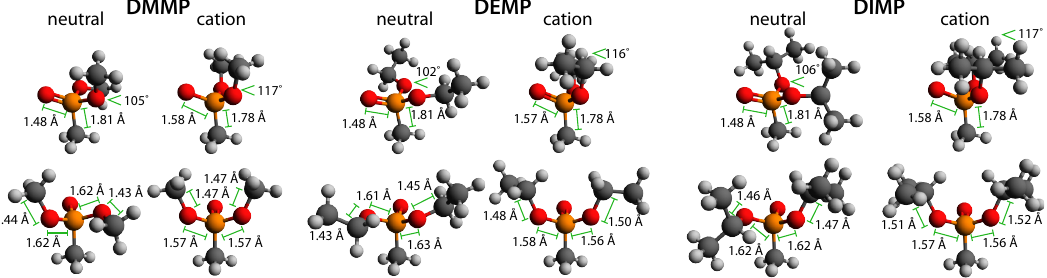
Figure 6. Neutral and cation geometries of DMMP, DEMP, and DIMP with selected bond lengths and angles